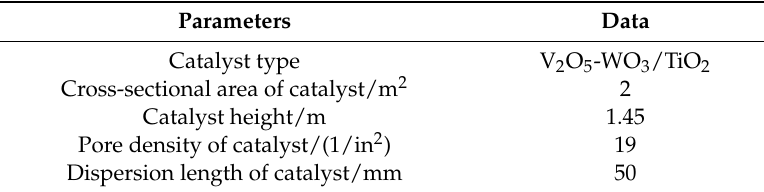
Table 1. Main parameters of the catalyst used in the selective catalytic reduction (SCR)